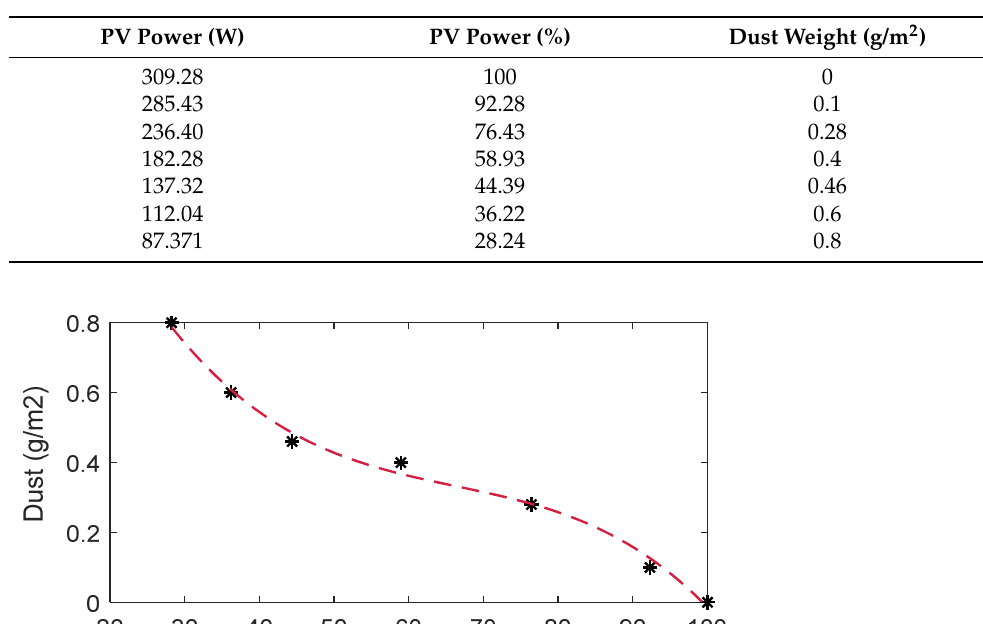
Table 2. Normalized PV output power versus dust weight.